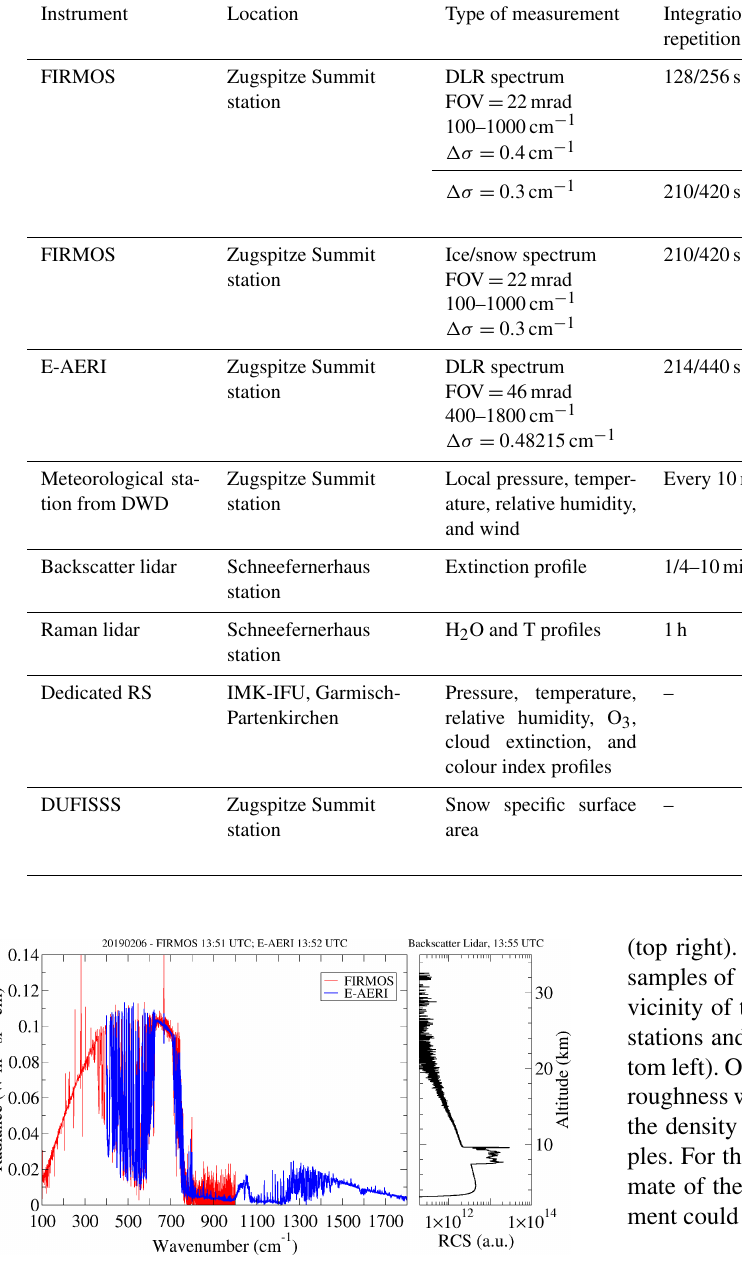
Figure 5. FIRMOS and E-AERI spectra simultaneously acquired in presence of a cirrus cloud on 6 February 2019 and the corresponding lidar RCS